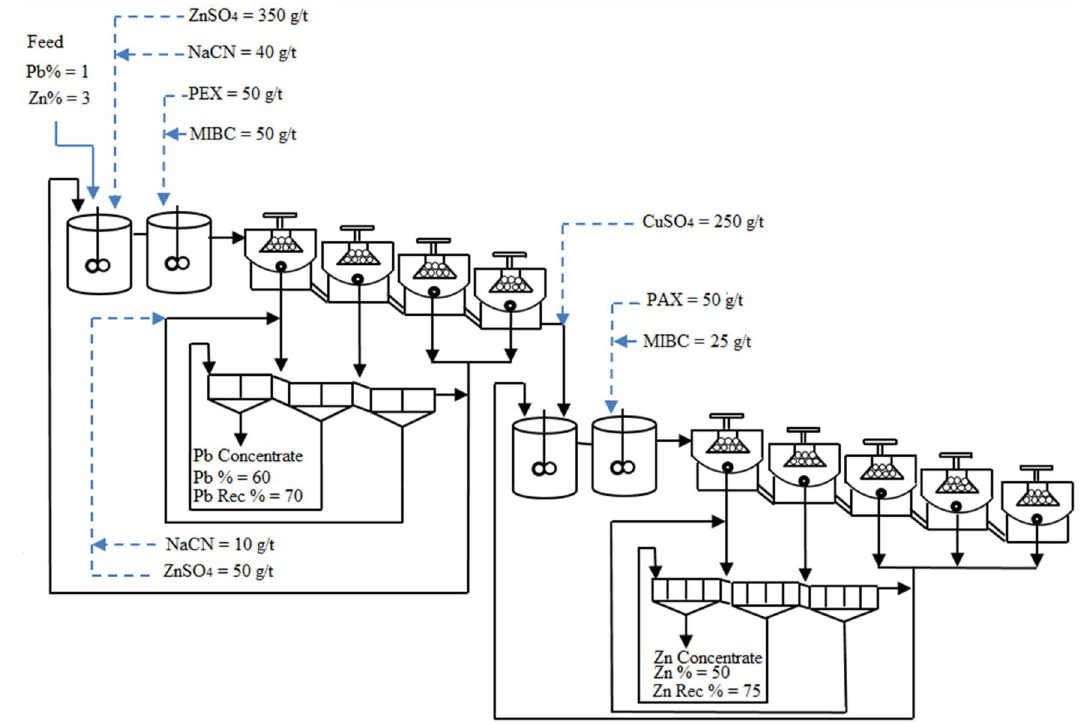
Figure 1. The schematic process flow diagram of actual flotation